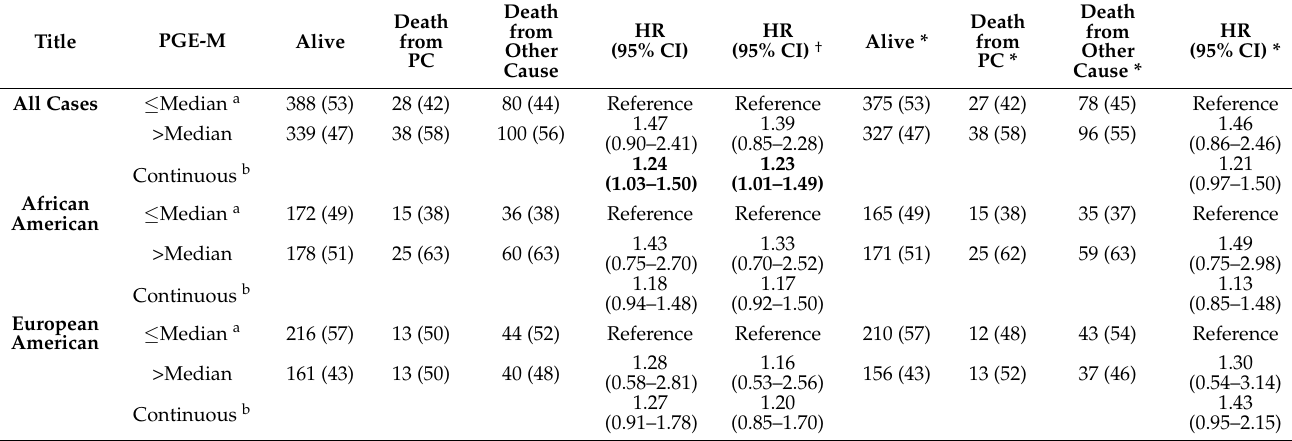
Table 4. Association of urinary PGE-M levels with prostate cancer-specific mortality among prostate cancer